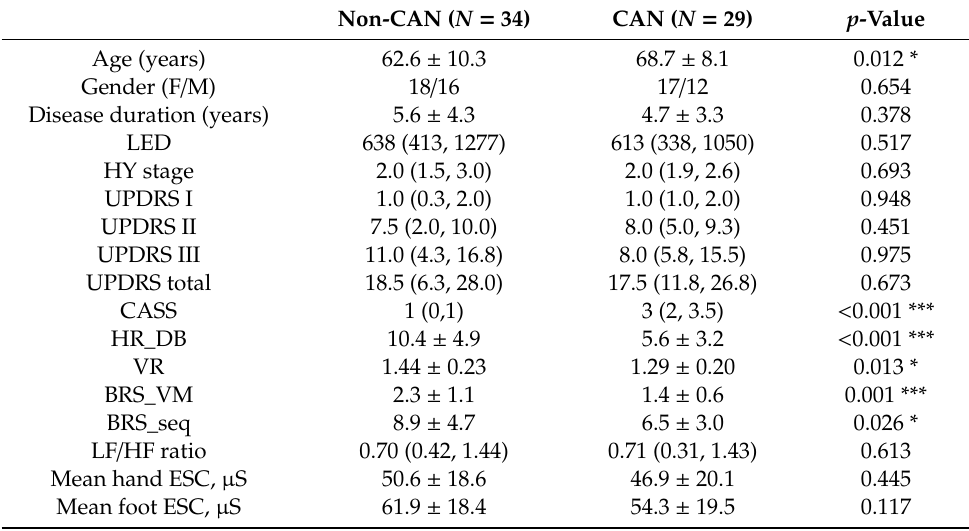
Table 3. Comparison between patients with or without cardiovascular autonomic